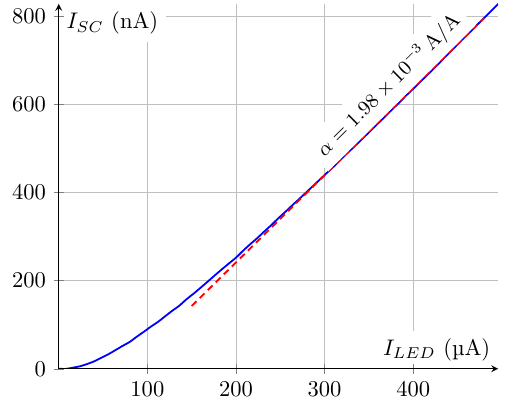
Figure 5. Input-output characterization of the optocoupler. I LED is the input current and I SC is the short-circuit output